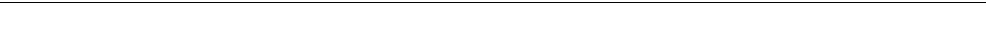
Table 1. Changes in Student Qualitative Definitions for Key Terms from Presurvey to